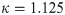
Improved low-activity fixed point of the model.Population-averaged firing rates for κ=1.125 encoded in color (A) predicted by the analytical theory and (B) obtained from the full simulation of the spiking network. Same display as in Fig 3. C Analytical versus simulated firing rates (black dots) and identity line (gray). D Histogram of population-averaged simulated firing rates. Same display as in Fig 3.